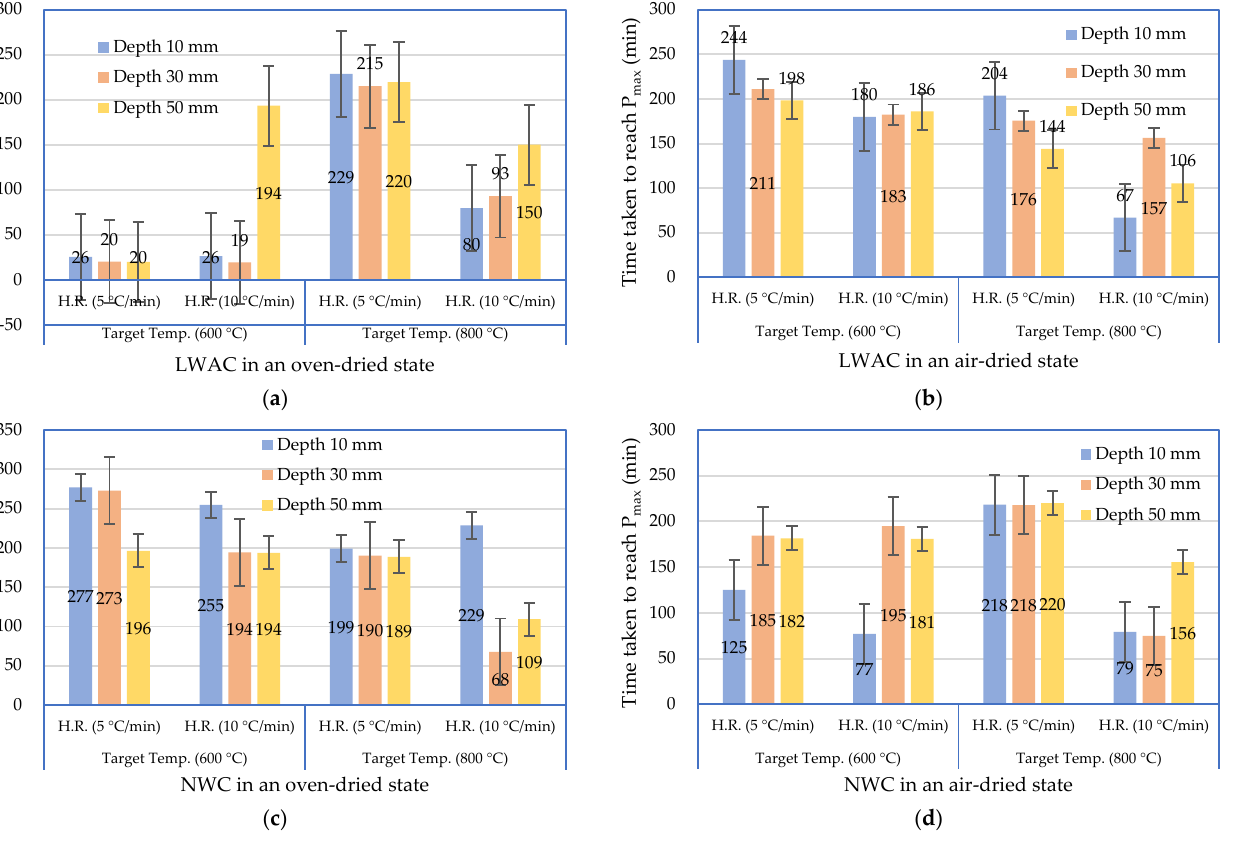
Figure 29. The time at which the maximum pore pressure occurred under different test conditions: ( a ) LWAC in an oven-dried state; ( b ) LWAC in an air-dried state; ( c ) NWC in an oven-dried state; ( d ) NWC in an air-dried state.